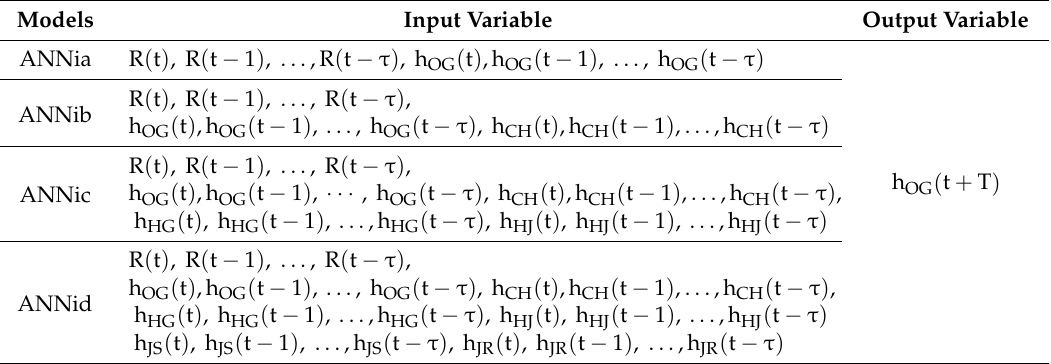
Table 2. Four groups of artificial neural network models with input variables (model configuration).